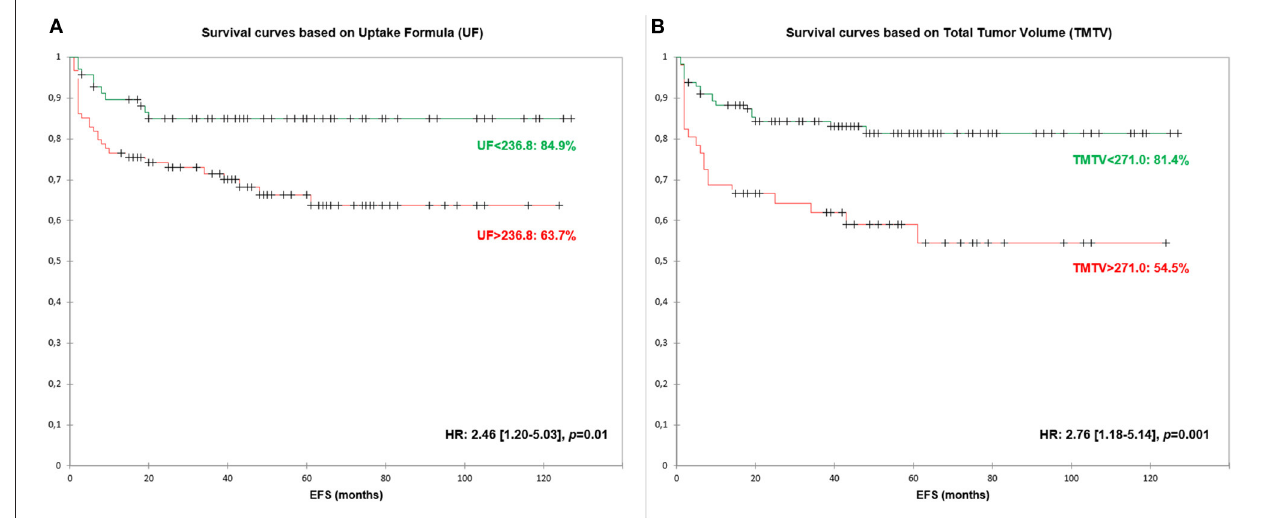
FIGURE 3 | Event-Free Survival (EFS) curves based on Uptake Formula [UF— (A) ] and Total Metabolic Tumor Volume [TMTV— (B) ].